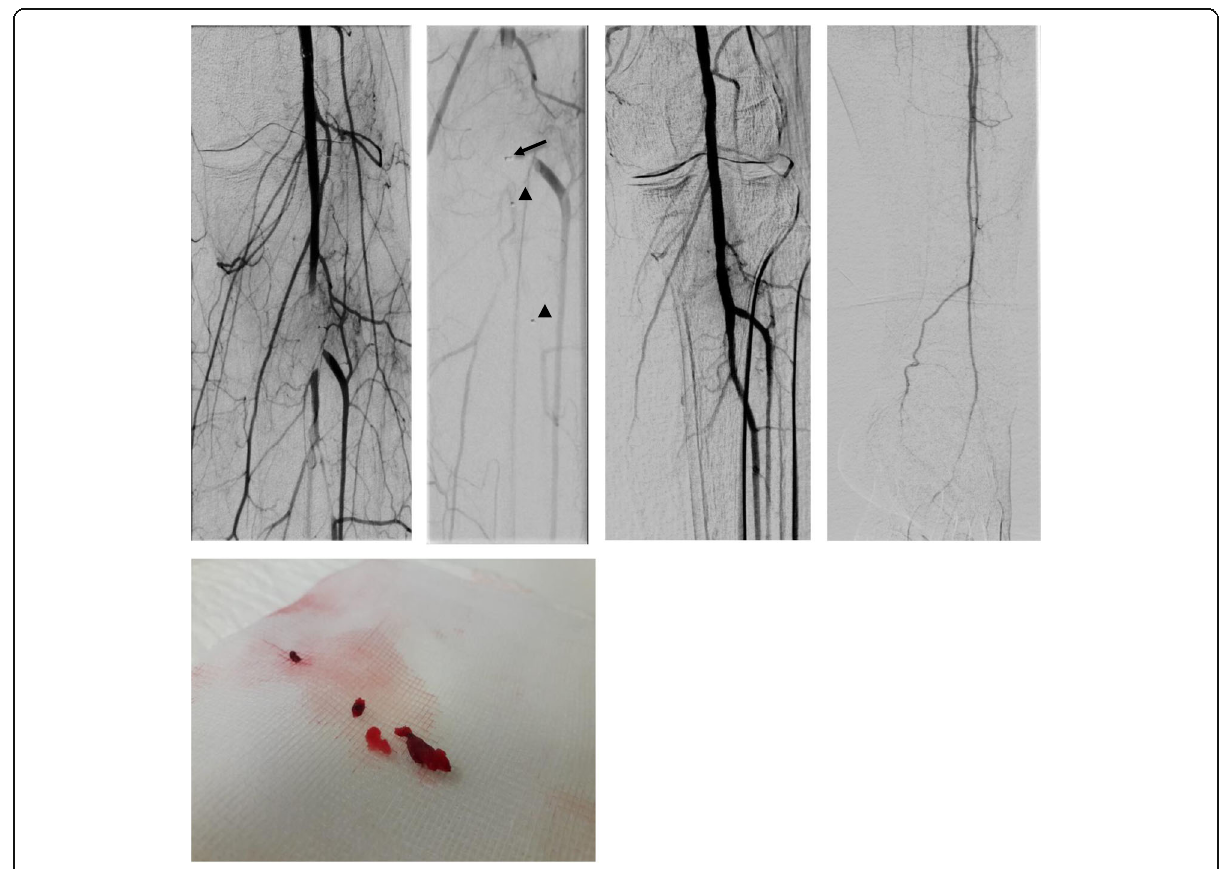
Fig. 1 a acute foreign body embolisation caused by accidentaly pushing the Mynx sealant into the artery during application of the MynxGrip closure device b advancement of the SOFIA aspiration catheter (black arrow) to the proximal end of the foreign body and deploying the pRESET over the foreign body (arrow heads) c digital subtraction angiography documents regular flow after complete removal of the foreign body d final picture of the leg arteries showing absence of distal embolization of the foreign body with previously known chronic occlusion of the posterior tibial artery e removed foreign body (Mynx PEG